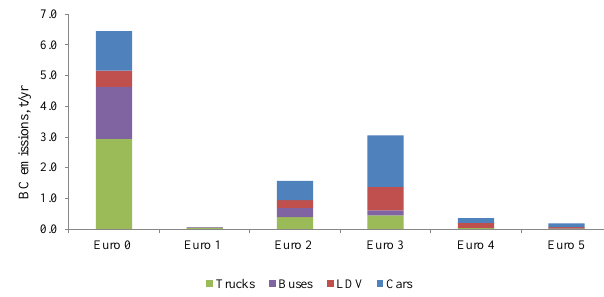
Fig. 2. BC emissions in Murmansk City by ecological class and vehicle type (t).